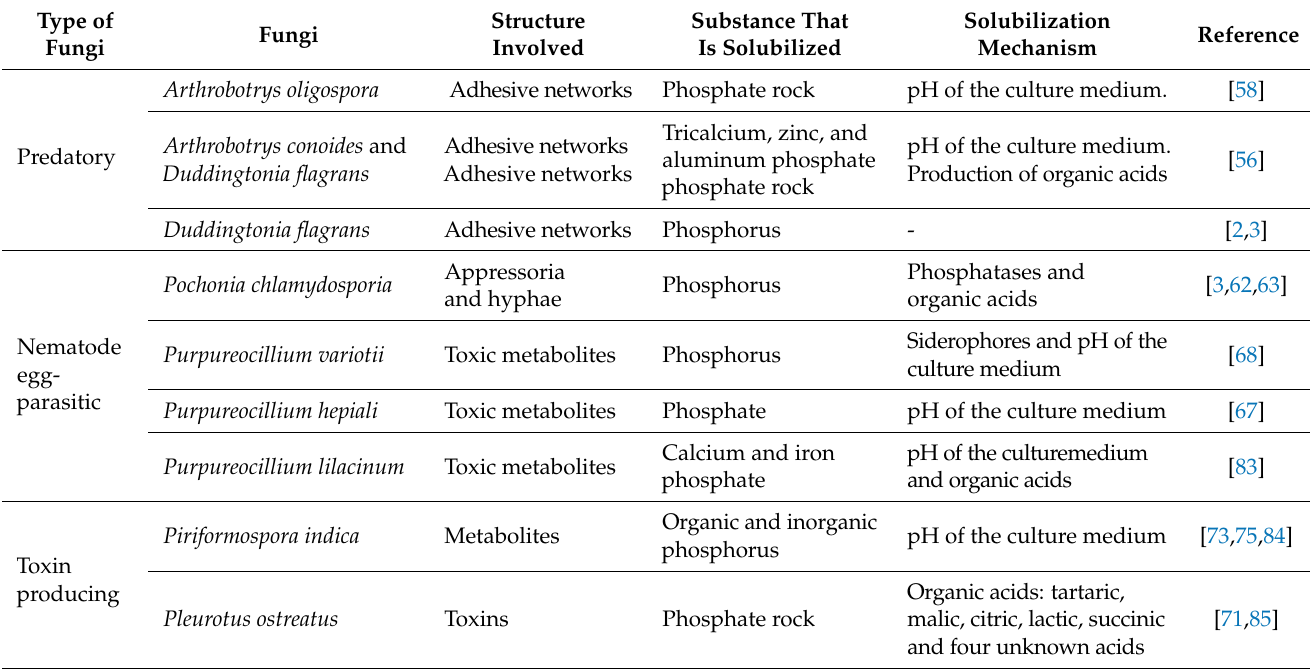
Table 1. Fungi known as nematophagous and P